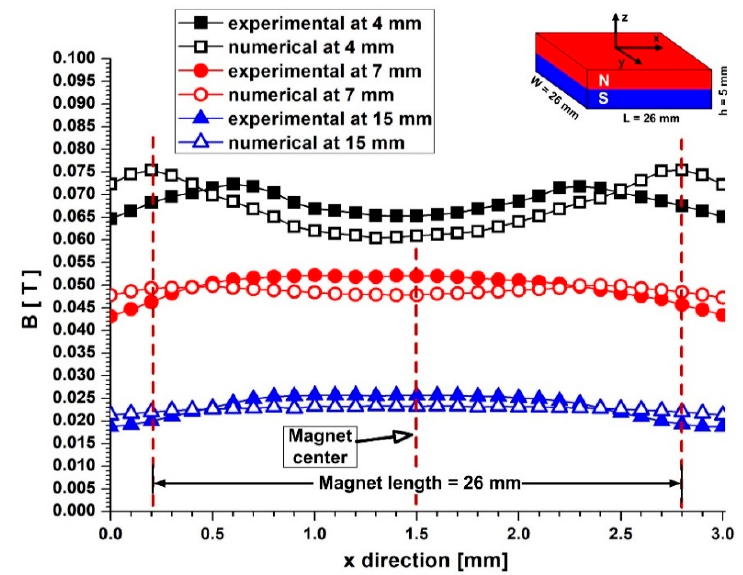
Figure 9. A magnetic field generated by the permanent ferrite magnet used in the experimental investigation. The ferrite magnet dimension and axis association: The used magnet has an axial polarization indicated in the figures; a comparison between the calculated and experimentally measured magnetic flux density produced by the ferrite type permanent magnet against the distance from the magnet surface (along axis Z). Experimental measurement was done using an F.W. Bell Gaussmeter, model 5080, and the magnetic field was obtained from numerical simulations using FEMM 4.2 software. The plot shows that the numerical solution of the magnetic field agrees well with the experimentally measured values. The differences are probably due to the precise position of the gaussmeter hole.